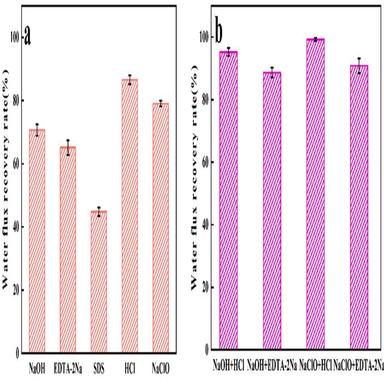
The water flux recovery rate: (a) Monocomponent washing agents. (b) Composite washing agents.